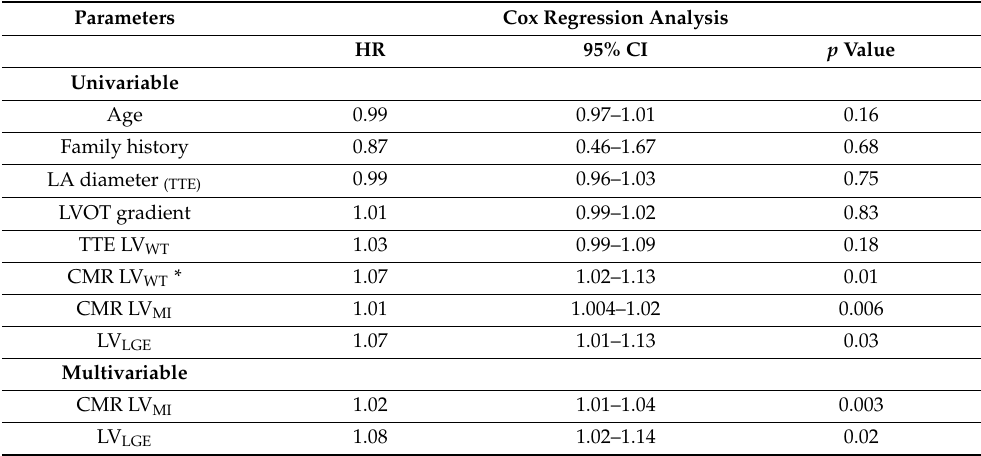
ventricular arrhythmia.